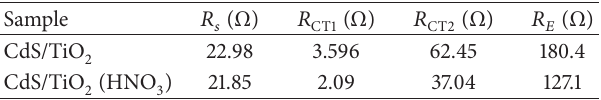
Table 2: Electrochemical parameters of reference and HNO treated solar